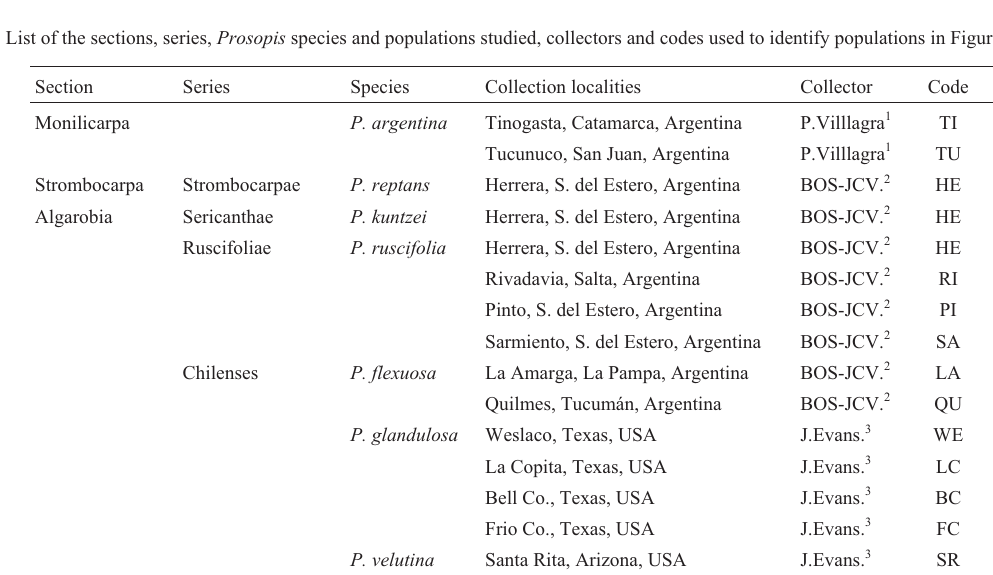
Figure 1 - Map indicating the location of the sampled populations. For references see Table